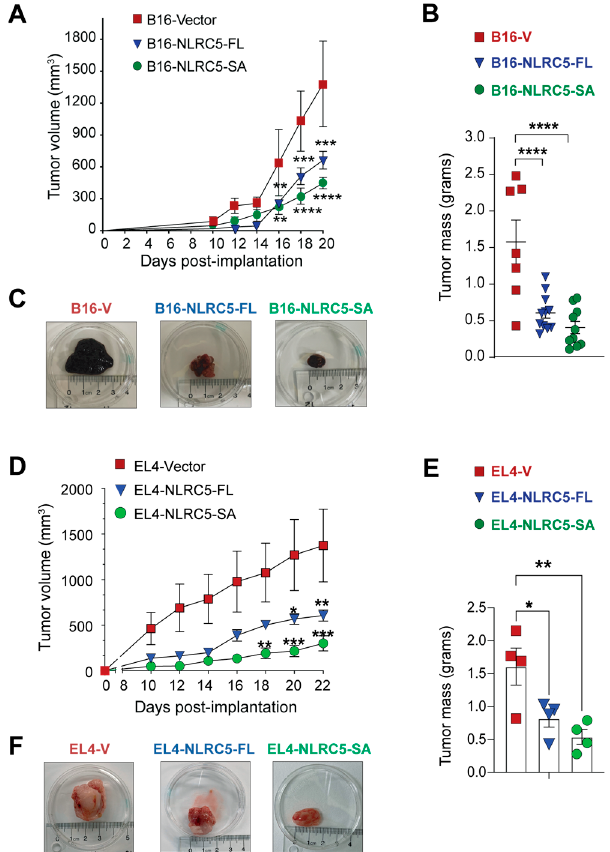
Figure 2. Control of B16 melanoma and EL4 lymphoma tumor growth by NLRC5-SA. Syngeneic C57BL/6 mice were inoculated subcutaneously with 1 × 10 5 B16-vector, B16-NLRC5-FL or B16- NLRC5-SA ( A – C ; n = 7–11 per group) or 5 × 10 5 EL4-vector, EL4-NLRC5-FL or EL4-NLRC5-SA cells ( D – F ; 4 mice per group). Tumor growth curve, monitored every 2–3 days ( A , D ). Tumor mass at the endpoint ( B , E ). Representative tumors formed by each tumor line at the endpoint ( C , F ). Statistical comparisons (in A , B , D , E ): mean ± SE; two-way ANOVA with Tukey’s multiple comparison test. * p < 0.05, ** p < 0.01, *** p < 0.001, **** p < 0.0001.